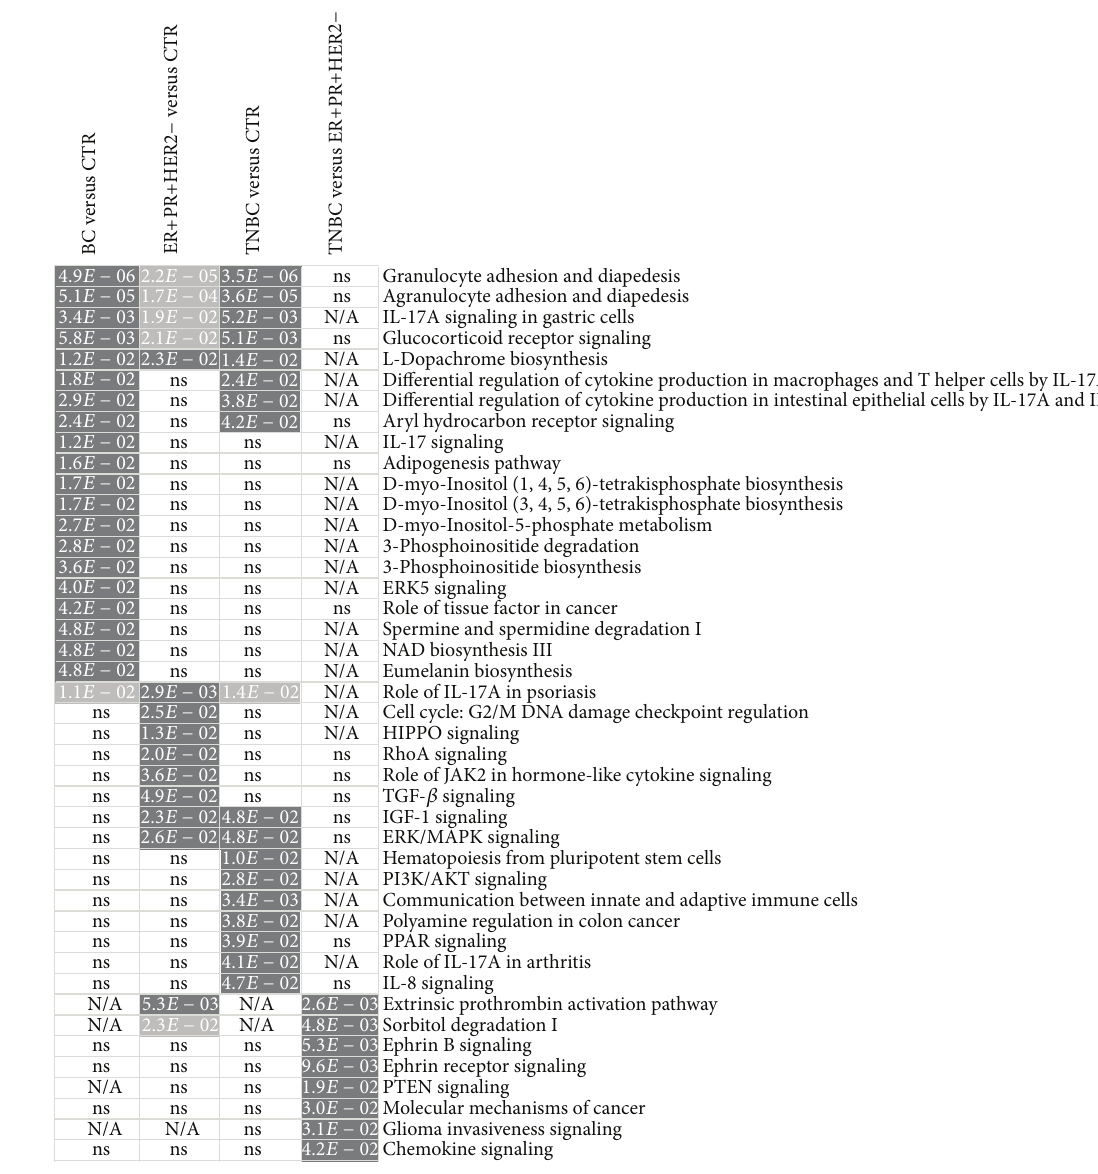
Figure4:Heatmapofthesignificantcanonicalpathwaysinthefourdatasetsofdifferentiallyexpressedgenes:BCversusCTR,ER+PR+HER − versus CTR, TNBC (ER − PR − HER − ) versus CTR, and TNBC versus ER+PR+HER − subgroup. The significance of the association between canonical pathways and each dataset was assessed in IPA by Fischer’s exact test ( 𝑝 < 0.05 ). The darkest color was assigned to the smallest 𝑝 value for a canonical pathway among all datasets, while uncolored boxes indicate the nonsignificant canonical pathways (ns) or their absence